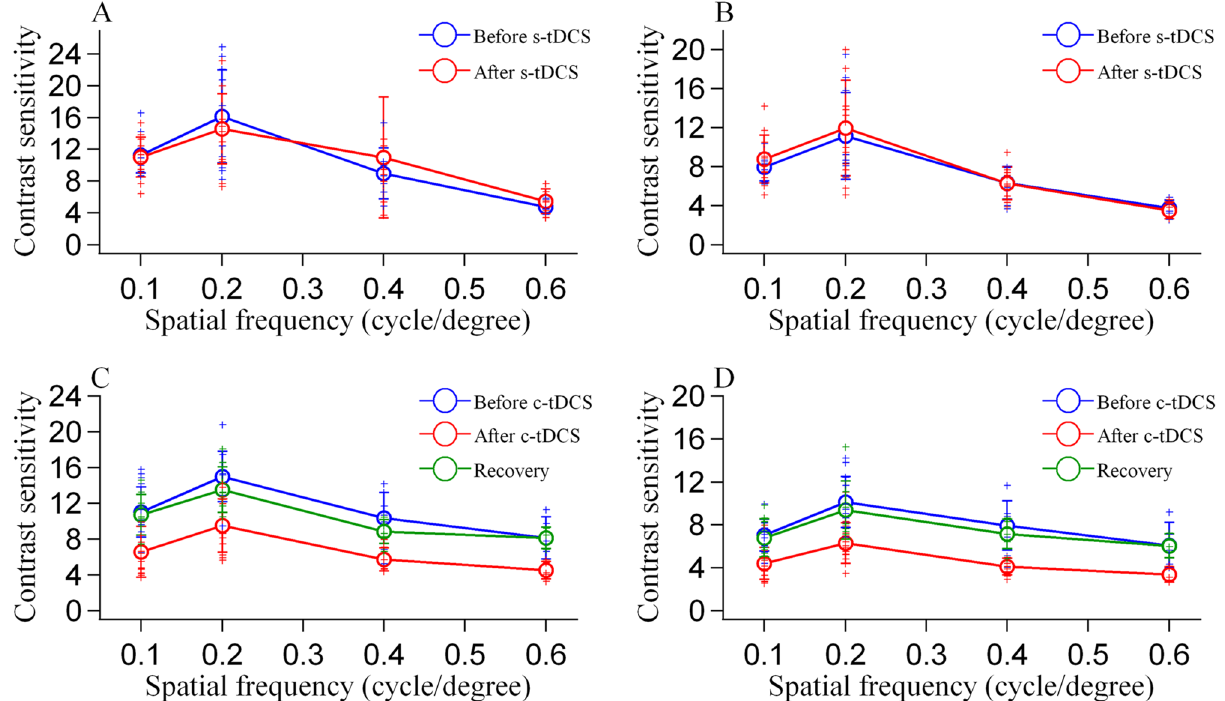
Figure 5. Contrast sensitivity of V1 neurons with different preferred spatial frequencies before and after sham (s)-tDCS and cathode (c)-tDCS in A7. The contrast sensitivity is expressed as the inverse of threshold contrast computed by ROC analysis at the performance accuracy of 70.7% and 79.3%, respectively. ( A , B ) contrast sensitivity of V1 neurons at performance accuracy of 70.7% ( A ) and 79.3% ( B ) before and after s-tDCS. (C&D) contrast sensitivity of V1 neurons at performance accuracy of 70.7% ( C ) and 79.3% ( D ) before and after c-tDCS in A7 as well as after recovery of c-tDCS effect. Crosses with different color in each plot represent individual